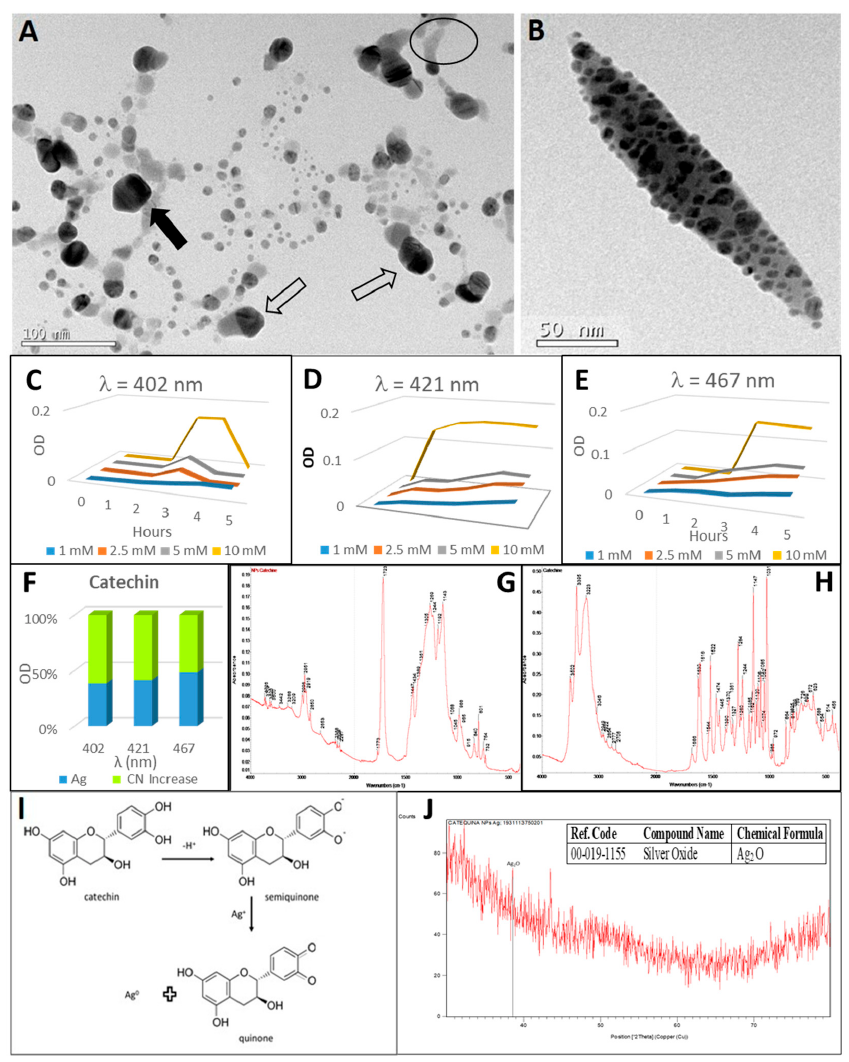
Figure 9. Analysis of catechin-synthesised silver nanoparticles. ( A ) TEM image of pentagonal (solid arrow) and polyhedral (hollow arrow) AgNPs prior to cyanide treatment. ( B ) TEM image of AgNPs after treatment with cyanide. ( C – E ) Synthesis of silver nanoparticles by the reaction of different AgNO 3 concentrations with catechin for 5 h (in one-hour intervals). ( C ) Maximum at 402 nm wavelength (20 nm diameter nanoparticles); ( D ) 421 nm (50 nm diameter nanoparticles) and ( E ) maximum at wavelength 467 nm (80 nm diameter nanoparticles). ( F ) Relative increase of OD after cyanide addition to silver nanoparticles. ( G , H ) FTIR spectra of catechin-derived nanoparticles ( G ) and catechin ( H ). ( I ) Synthesis reaction of silver nanoparticles with catechin mediated by semiquinone and quinone formation. ( J ) XRD profile of the AgNPs obtained by the reaction of the catechin with AgNO 3 ; in the insert, the table with the identifications. Peaks identifying the presence of silver oxides have been indicated in the XRD diffractogram.